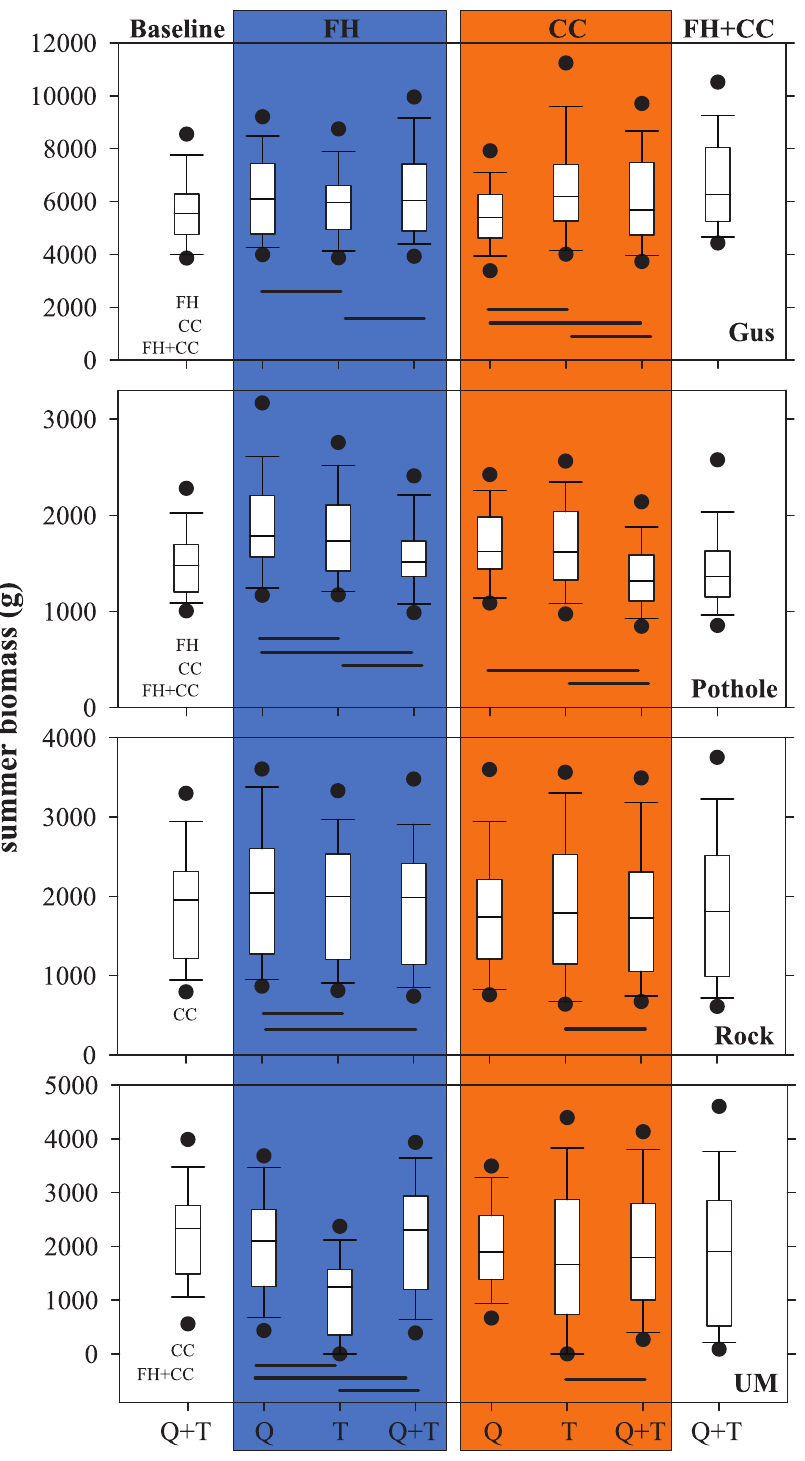
Fig 3. Influence of Flow and Temperature on Trout Biomass within each Scenario. Boxplots of mean total summer biomass (g) of trout in Gus Creek, Pothole Creek, Rock Creek, and Upper Mainstem (UM) from five replicate simulations over the entire study period. Each boxplot incorporates 63 data points of the mean of every year ’ s summer biomass per scenario. Gray boxes represent pairwise comparisons of the influence of flow (Q), stream temperature (T), and both (Q+T) within each scenario of forest harvest (FH) and